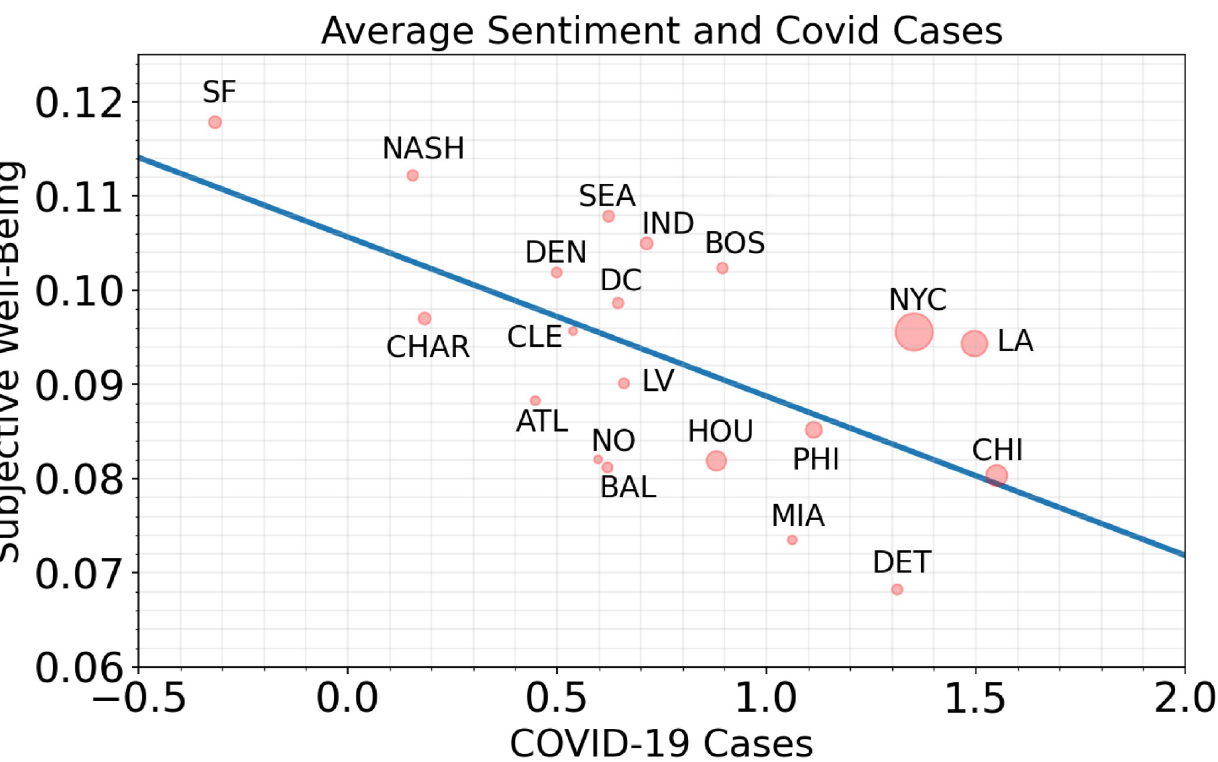
Fig 1. Average VADER score vs observed COVID-19 cases. The blue line displays the line of best fit for all data points. The size of the node is relative to the population size of the cities shown. The negative trajectory suggests that VADER scores are inversely correlated with the mean 7-day average of new COVID-19 cases per 1,000